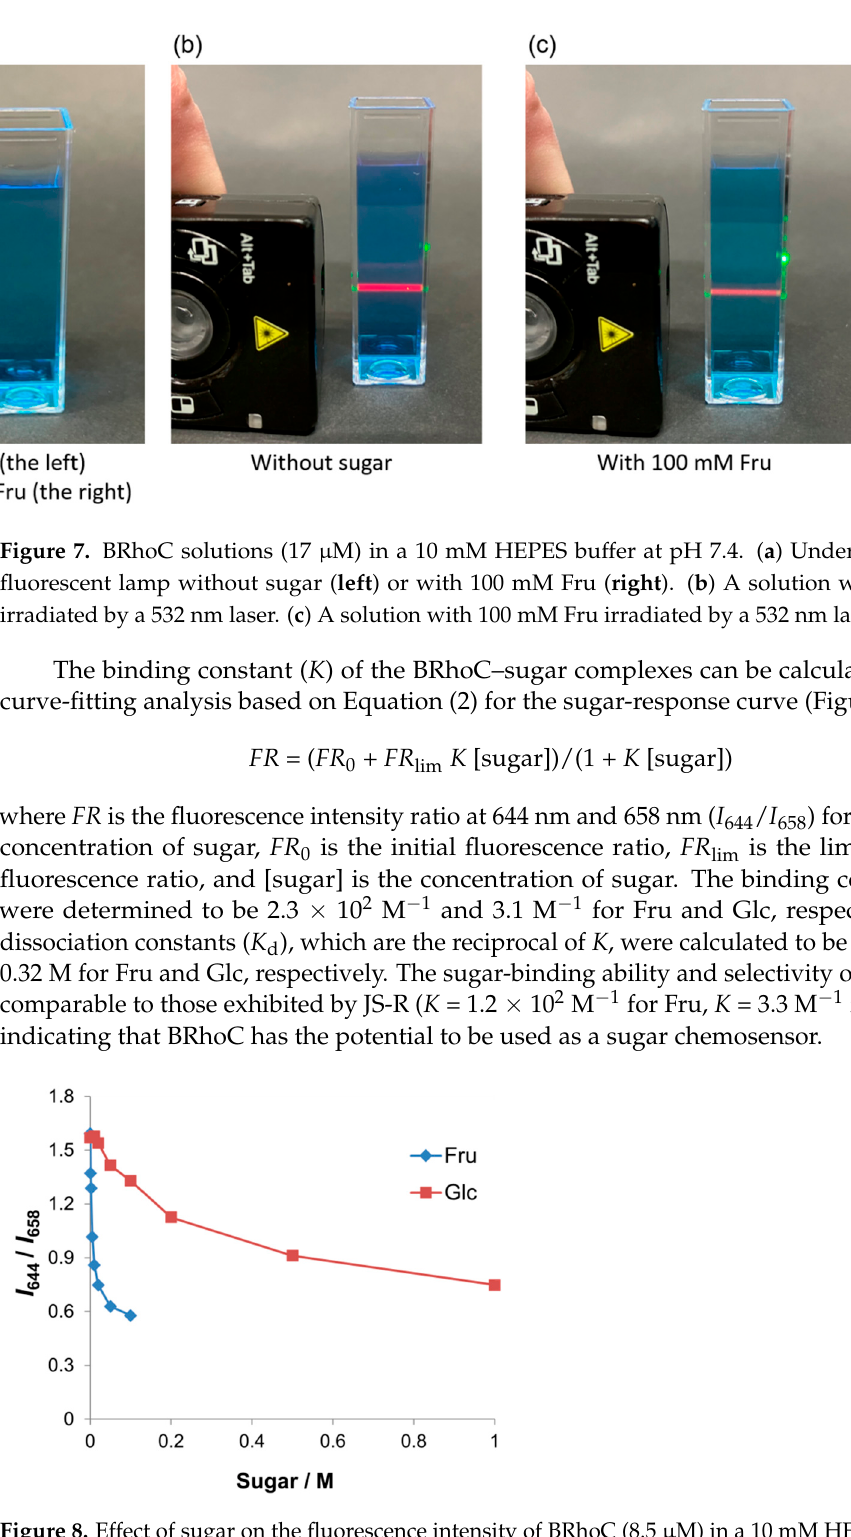
Figure 8. Effect of sugar on the fluorescence intensity of BRhoC (8.5 µ M) in a 10 mM HEPES buffer at pH 7.4. The fluorescence intensity of BRhoC was monitored at 644 nm when excited at 621 nm.